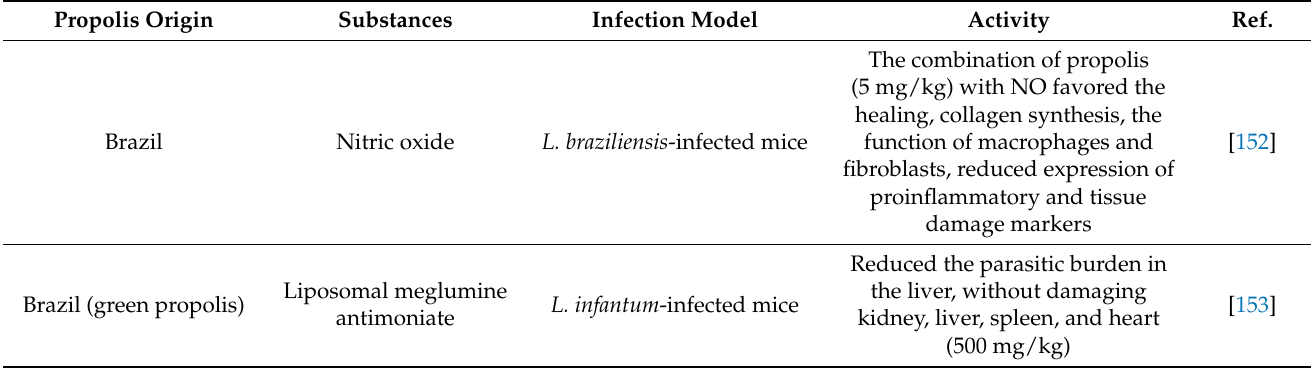
Table 14. Activity of Brazilian propolis on different Leishmania infection